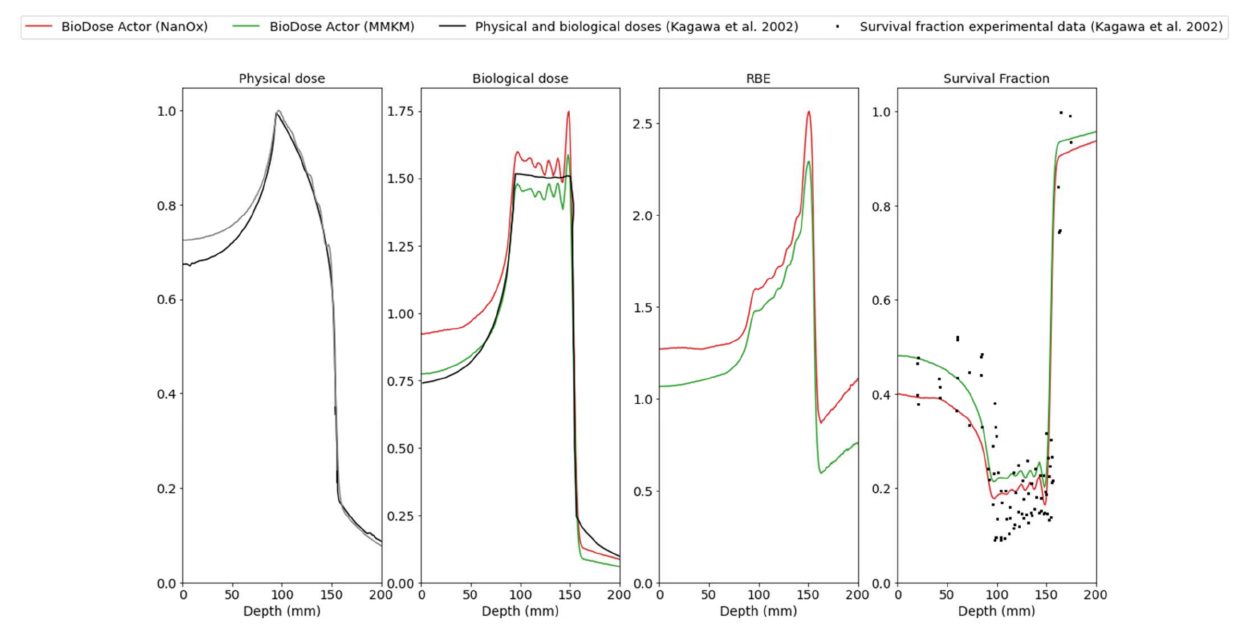
Figure 6. Physical dose (light grey), biological dose, RBE and survival fractions provided by the BioDoseActor as a function of target depth: NanOx model (red curve), mMKM model (green curve) and experimental data from Kagawa et al. [25] (black curves and dots) for the HIBMC 320 MeV/u carbon-ion beam line.